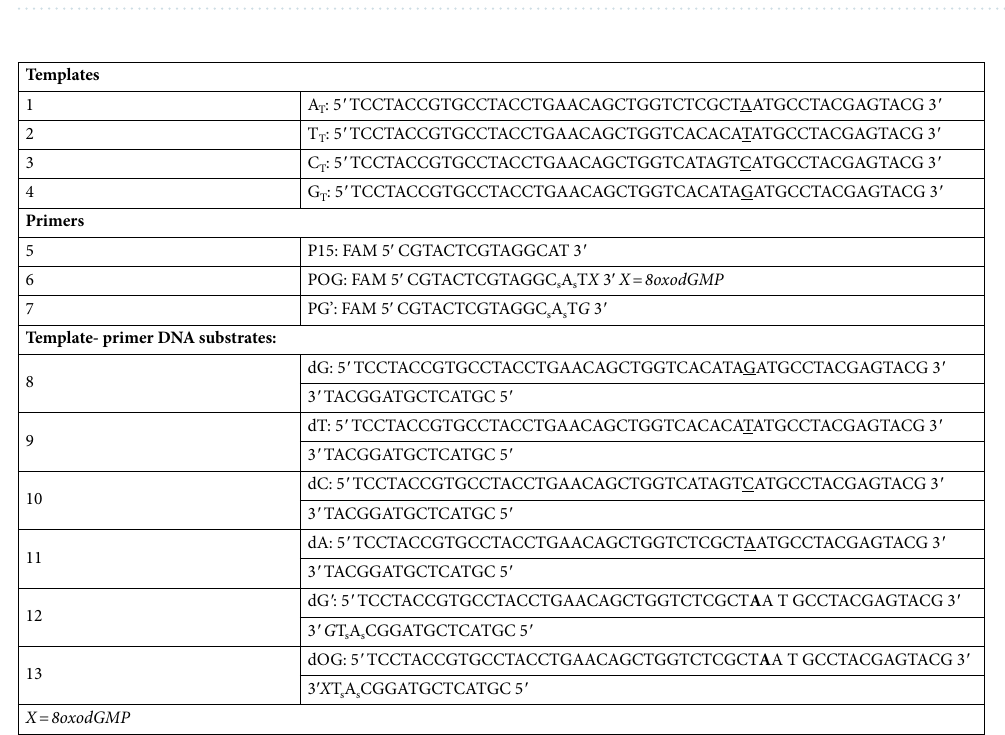
Table 1. List of DNA substrates. The template (1–4) and primer (5–7) oligonucleotides used and their corresponding DNA duplexes (8–13) are displayed. "s" denotes the phosphorothioate linkage between the nucleotides. For each of the template-primer duplexes, the templating nucleotides are underlined. In the case of the DNA duplexes utilized to asses exonuclease activity, the nucleotide present at the 3 ′ end is highlighted in italics and the corresponding nucleotide on the template strand is show in